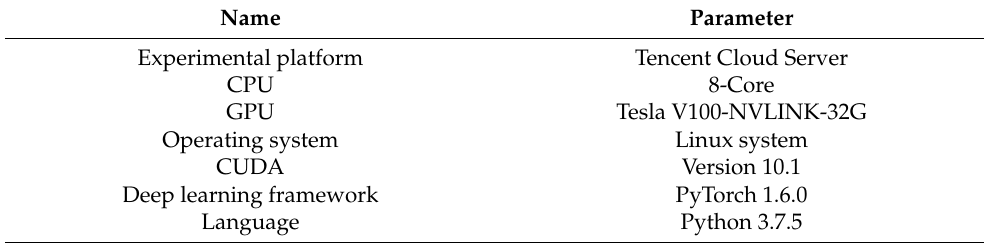
Table 1. Hardware and software parameters of the experimental platform.